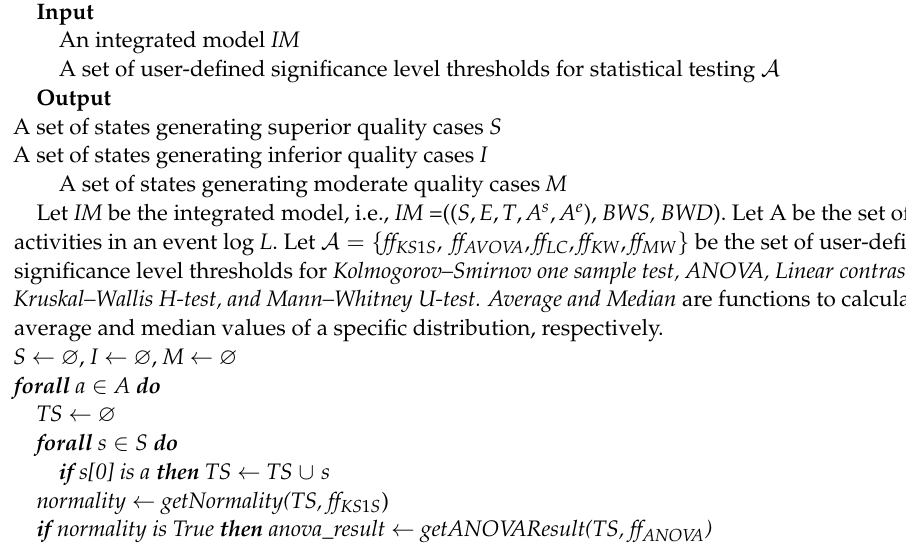
Algorithm 2 IdentifyingSignificantMachines(IM, A